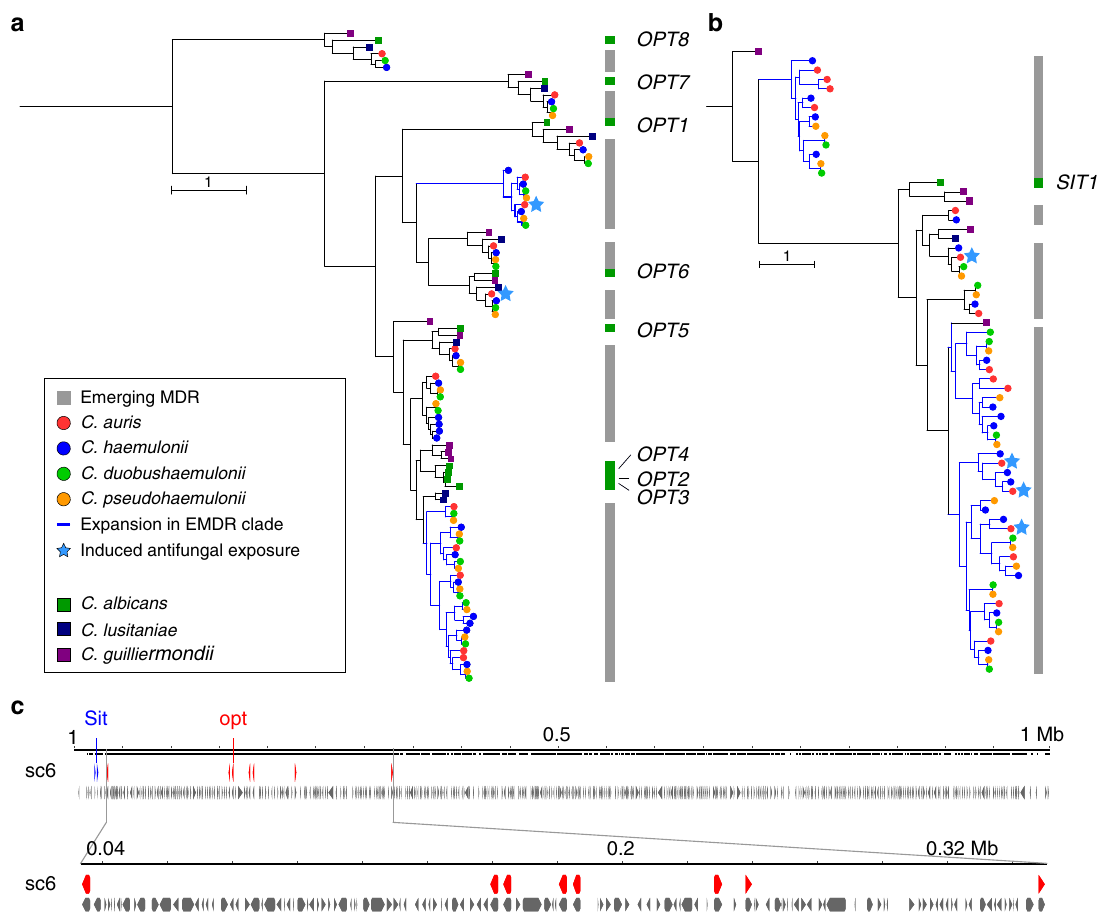
Fig. 4 Phylogenetic relationships of expanded families of transporters. a , b Maximum likelihood phylogenetic trees showing expansion of oligopeptide transporters ( OPT ) and siderophore iron transporters ( SIT ) families in C. auris and C. haemulonii , C. duobushaemulonii and C. pseudohaemulonii . Each species has a color code and lineage-speci fi c expansions (blue branches) can be seen in C. auris and closely related species relative to the close ancestor C. lusitaniae and C. albicans . Orthologs of OPT and SIT transporters in C. albicans are depicted alongside each tree. c Chromosome view depicting genes and orientation located in chromosome 6 (B8441 scaffold05). This region highlights expansion and tandem duplication of eight OPT class transporters (in